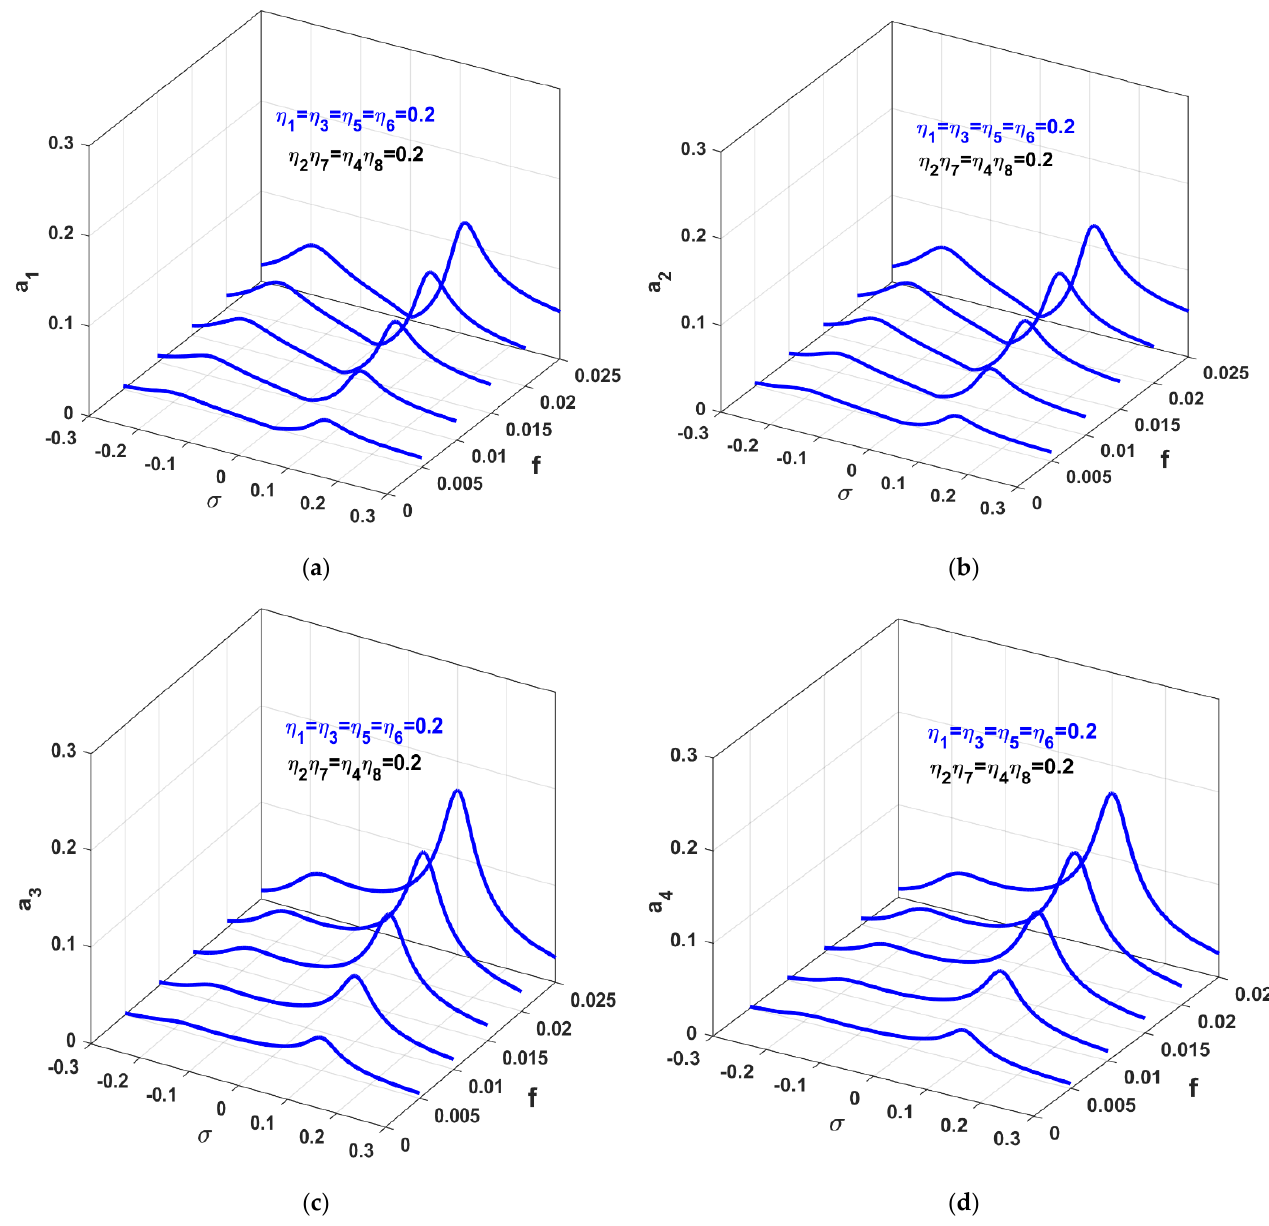
Figure 5. Vibration amplitudes of the rotor system and LIPPF-controller using 𝜎 as a bifurcation parameter when 𝑓 = 0.005,0.01,0.015,0.02, and 0.025 : ( a ) vibration amplitude in 𝑋 1 direction, ( b ) vibration amplitude in 𝑋 2 direction, and ( c , d) vibration amplitudes of the LIPPF-controller.